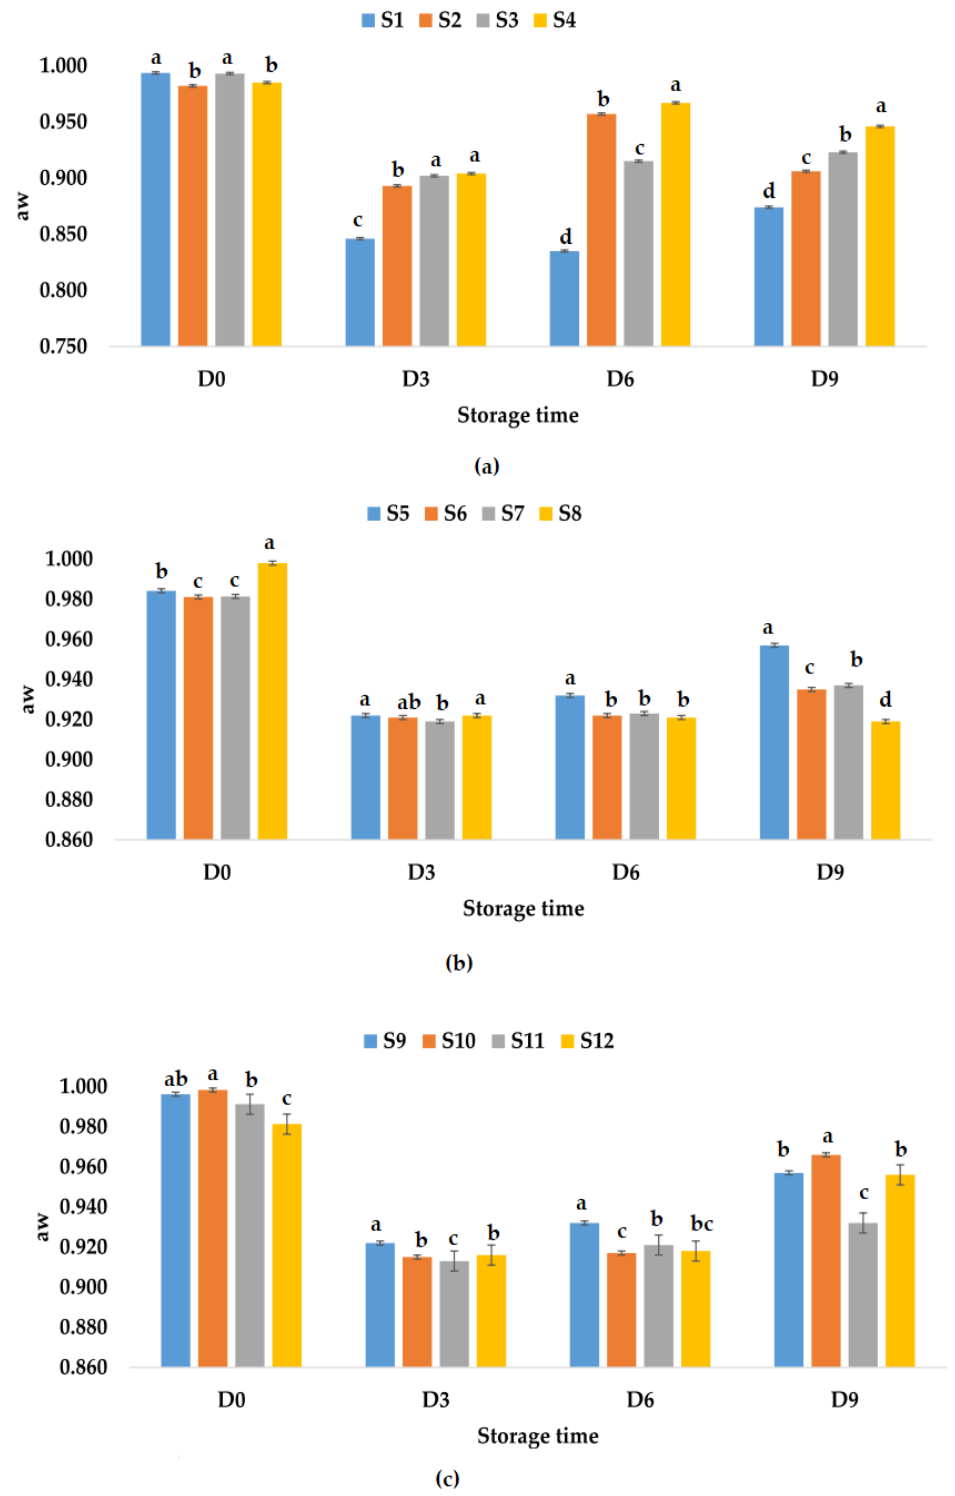
Figure 2. Variation in aw of juice samples during the storage period (D-day) at room temperature (20 ◦ C): ( a ) apple juice samples (S1, S2, S3, S4); ( b ) apple and pumpkin juice samples (S5, S6, S7, S8); ( c ) apple and pomegranate juice samples (S9, S10, S11, S12). Means with different lowercase letter indicate the significant differences ( p < 0.05) among the samples and were performed separately for each day of storage.